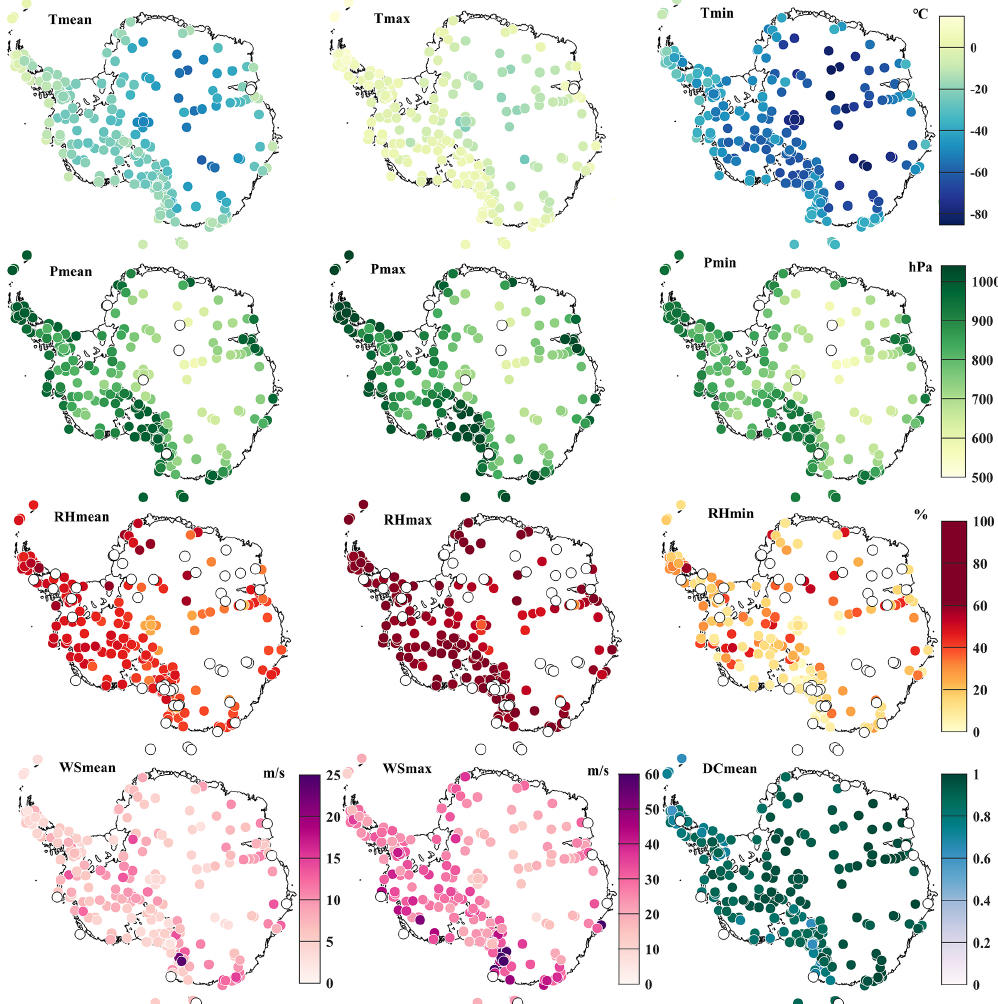
Figure 6. Spatial distribution of AWS multiyear 3h mean, maximum and minimum meteorological elements (temperature, pressure, relative humidity, wind speed) and daily mean constancy of the wind direction (DC) during 1980–2021. White circles represent the missing data. T mean is mean temperature, T max is maximum temperature, T min is minimum temperature, P mean is mean pressure, P max is maximum pressure, P min is minimum pressure, RH mean is mean relative humidity, RH max is maximum relative humidity, RH min is minimum relative humidity, WS mean is mean wind speed, WS max is maximum wind speed, and DC mean is daily mean constancy of the wind